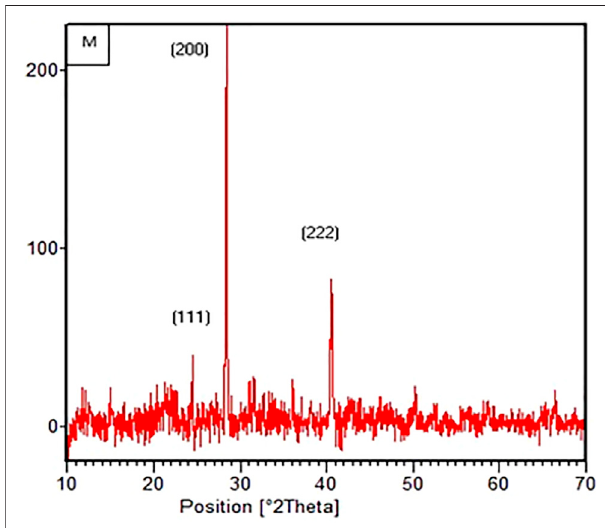
FIGURE 1 | X-ray diffraction spectroscopy of MgO